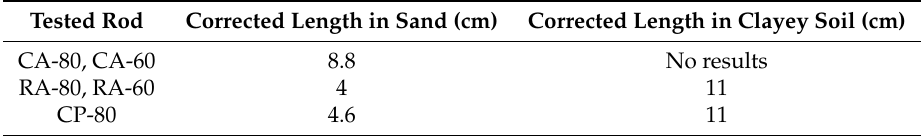
Table 8. Value of the equivalent length of the tested rods in both